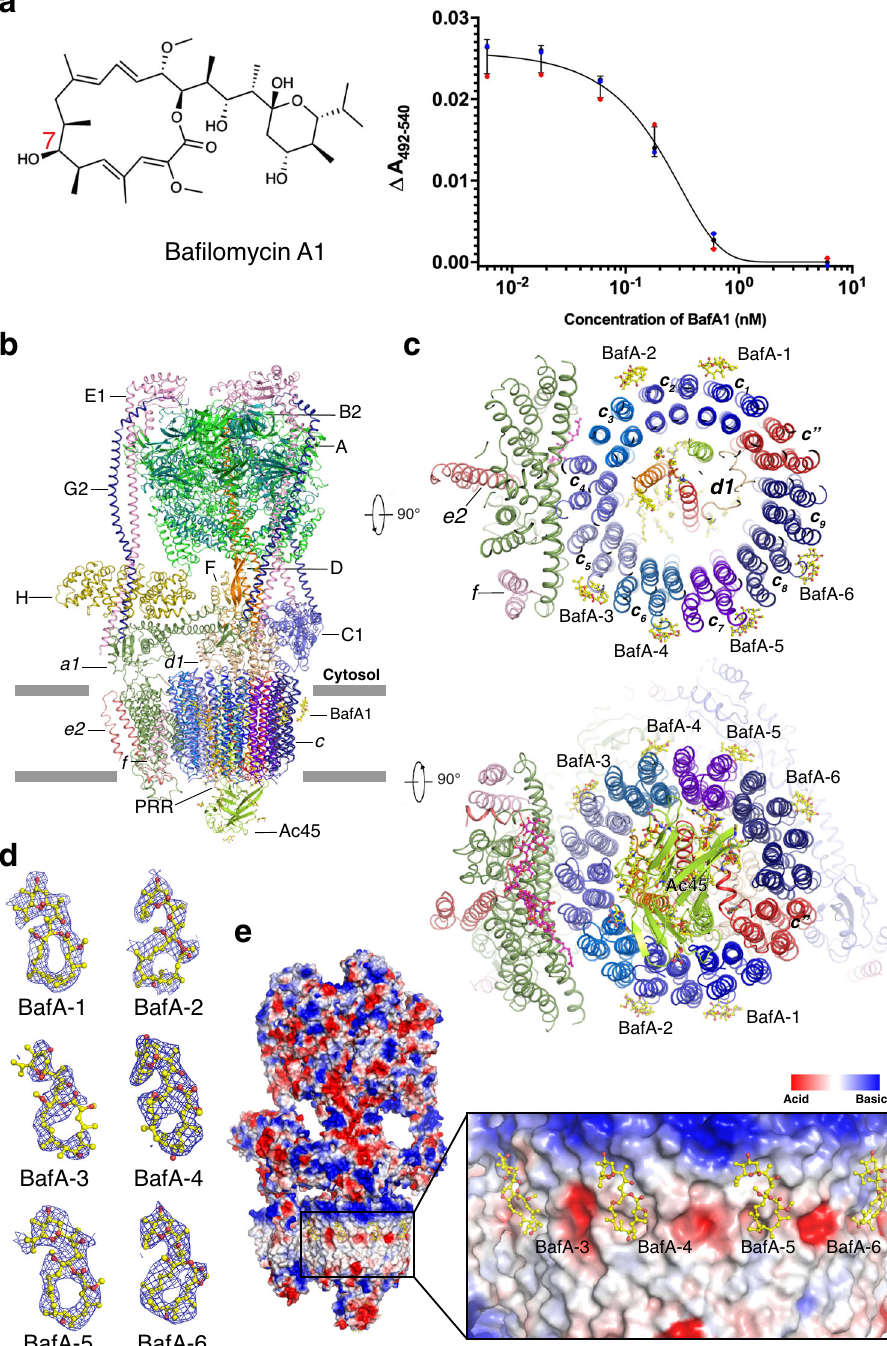
Fig. 1 Overall structure of the V-ATPase complex with ba fi lomycin A1. a Dose-dependent ATP-driven proton translocation assay. The concentrations of ba fi lomycin A1 (structure shown) in the assay were 0.006 nM, 0.018 nM, 0.06 nM, 0.18 nM, 0.6 nM, and 6 nM, respectively. The concentration of V- ATPase in the assay was 0.6 nM. Data are mean ± s.d. ( n = 3 independent experiments). The detail is described in the “ Methods ” section. b Overall structure showing ba fi lomycin A1 bound V-ATPase viewed from the side of the membrane. c The cytosolic and lumenal views of the V o domain of V- ATPase. d Cryo-EM maps of each ba fi lomycin A1 at 4 σ level. e Electrostatic surface representation of V-ATPase and ba fi lomycin A1 binding sites. Ba fi lomycin A1 is shown in yellow The interaction between ba fi lomycin A1 and V-ATPase . The yeast, rat, bovine, and human V-ATPase 10,12,30,31 , it suggests that the Dolichol-p-p-Glycan may play an important role in facilitating transmembrane helix 2 (TM2) of one subunit c and the TM4 of the proton translocation and/or the assembly of V o domain. The speci fi c function of Dolichol-p-p-Glycan in V-ATPase need to be further investigated. molecule (Fig. 3a). Residue M53, I56, V60, and I67 of one subunit